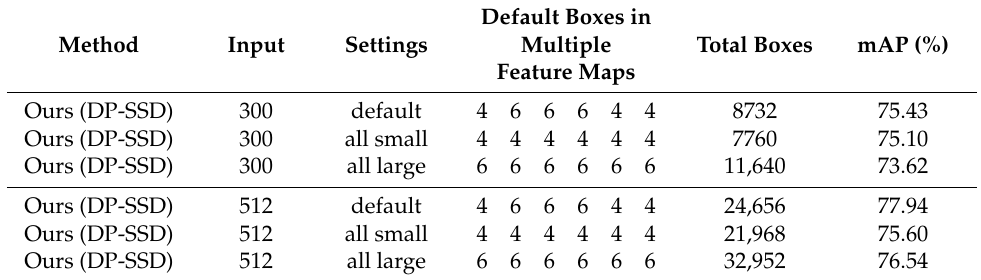
Table 5. Detection results of DP-SSD on UA-DETRAC test set using different number of default boxes in multiple feature maps. The training data is UA-DETRAC trainval dataset in this paper. The multiple feature maps are conv4_3_pb, fc7_pb, conv6_2_pb, conv7_2_pb, conv8_2_pb and conv9_2_pb, respectively. The default setting of using different number of default boxes (75.43% or 77.94%) is the same as that in Table 4. All models use the new default box size in Table 2 or Table